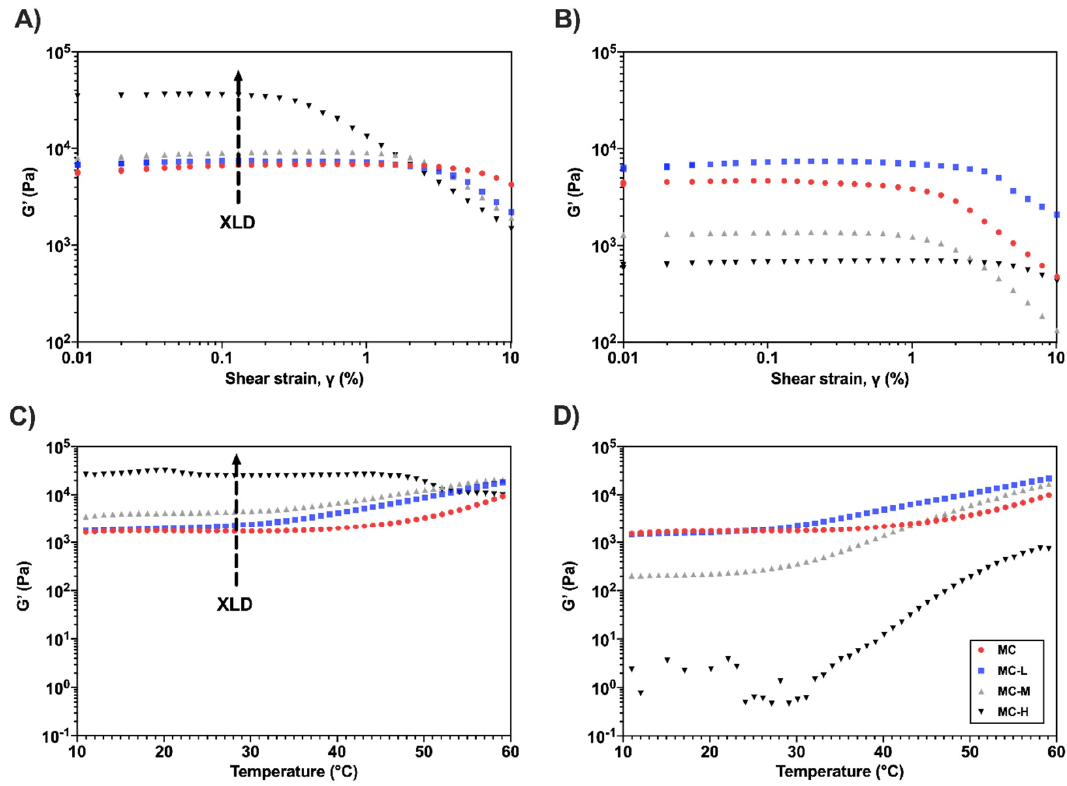
Figure 3. Representative G ′ vs. γ curves for strain sweep tests on MC samples at ( A ) pH = 4 and ( B ) pH = 12. Representative G ′ vs. T curves for temperature sweep tests on MC samples at ( C ) pH = 4 and ( D ) pH = 12.